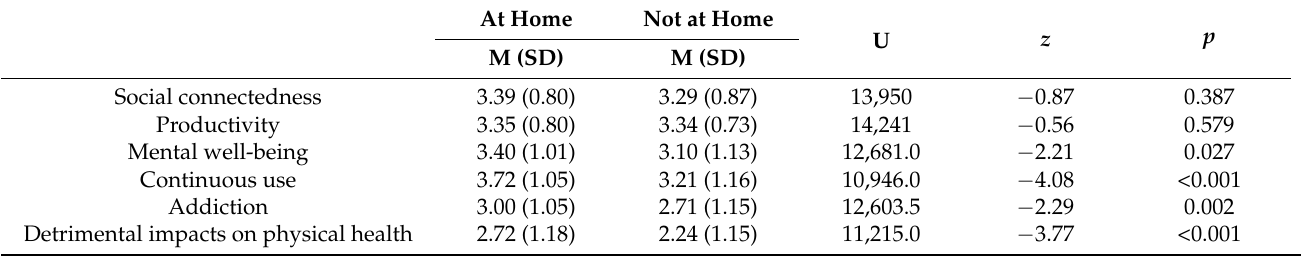
Table A7. Mobile Device Affinity and Usage since March 2020 Based on Workplace